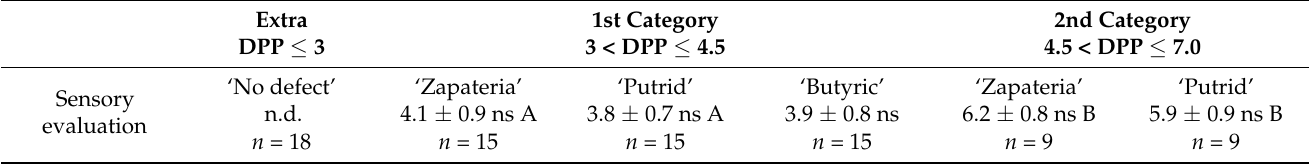
Table 1. Defect predominantly perceived (DPP) of Spanish-style table olive. Different lowercase letters mean a statistically significant difference between altered olives within the same category (one-way ANOVA followed by Tukey’s test, p < 0.05). Different uppercase letters mean a statistically significant difference between each altered olive in different categories (one-way ANOVA followed by Tukey’s test, p < 0.05).